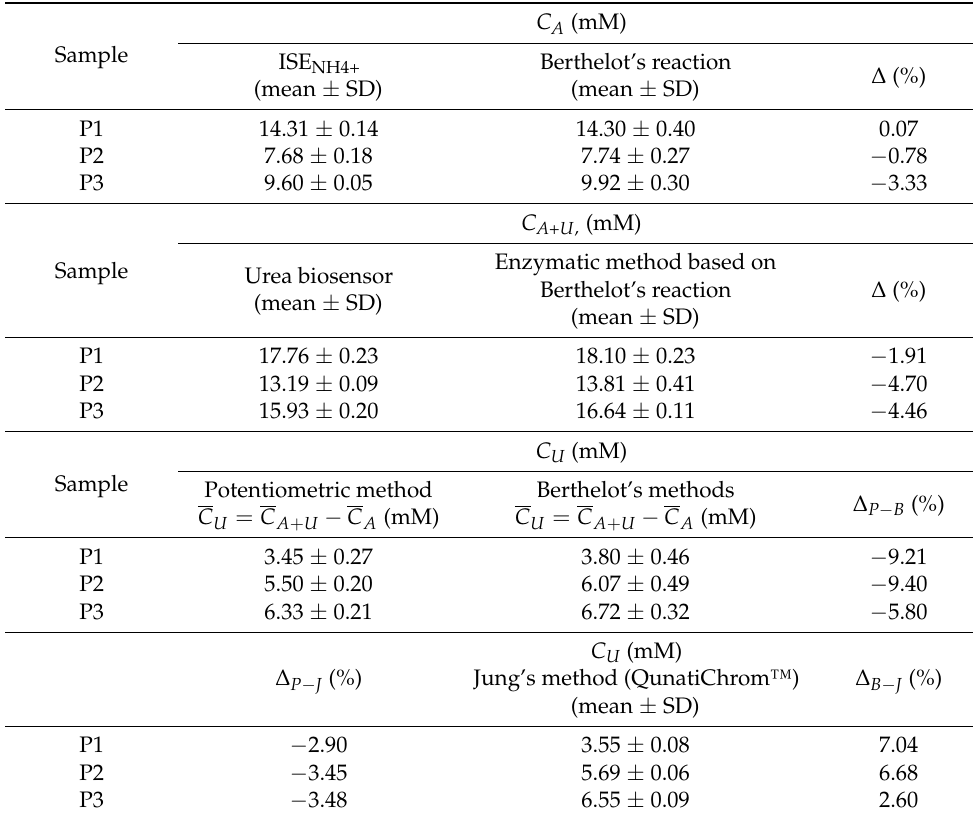
Table 4. Results of determination of ammonium and urea in human saliva by potentiometric sensors in reference to colorimetric methods ( ∆ = ( C − C Ref )/ C Ref